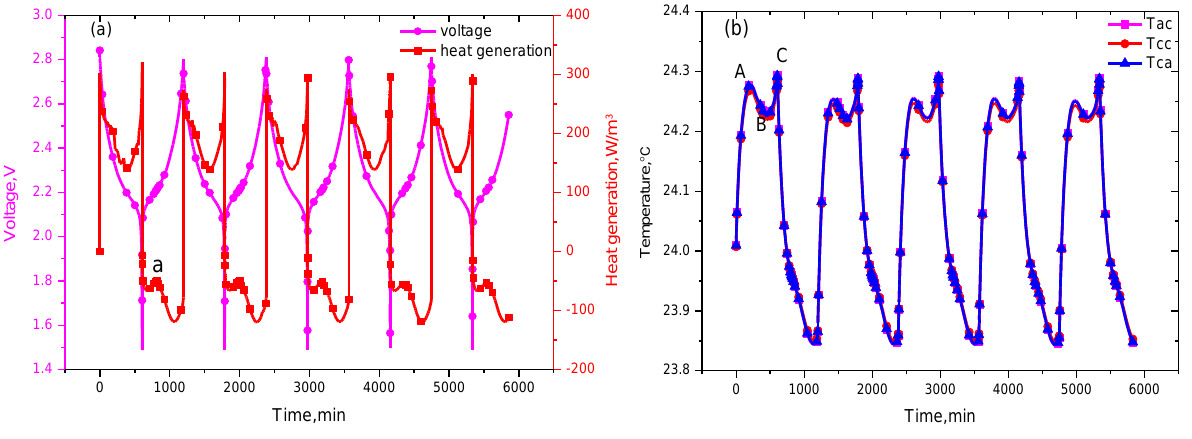
Figure 4. The profile of ( a ) voltage and heat sources; and ( b ) the temperature variation curve at 0.1 C